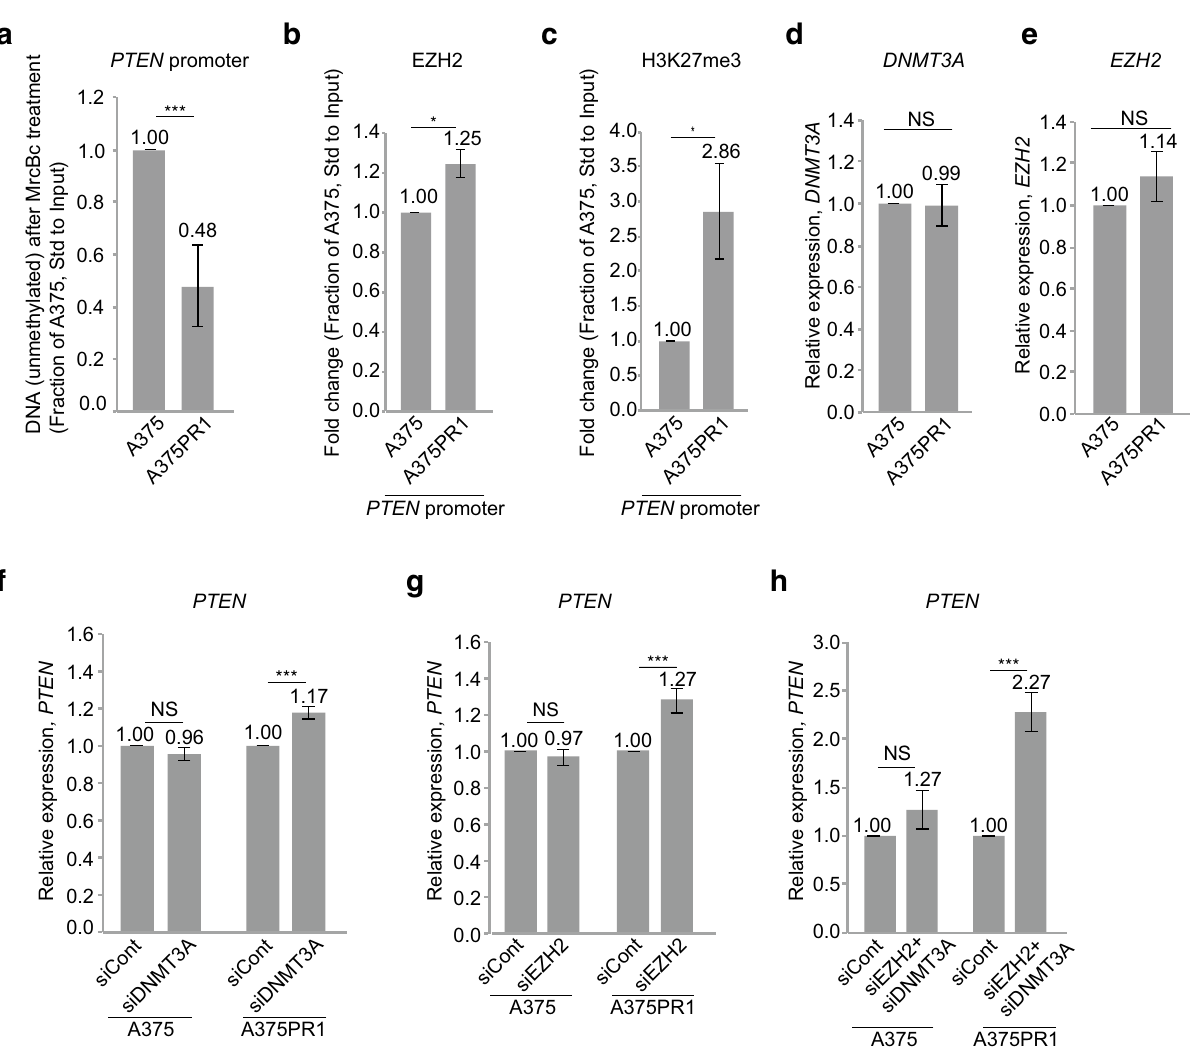
Figure 3. Characterization of the PTEN promoter in A375 and A375PR1 cell lines. ( a ) qRTPCR measuring PTEN promoter CpG methylation, as determined by the remaining (unmethylated) DNA upon treatment with the methyl-cytosine-specific restriction enzyme McrBc (n = 3). ( b–c ) ChIP followed by qRTPCR analysis measuring the levels of ( b ) EZH2 and ( c ) H3K27me3 at the PTEN promoter in A375 and A375PR1 cell lines (n = 3). ( d – e ) qRTPCR measuring baseline expression levels of ( d ) DNMT3A and ( e ) EZH2 in A375 and A375PR1 cell lines (n = 3). ( f – g ) qRTPCR measuring the expression levels of PTEN following siRNA induced knockdown of ( f ) DNMT3A and ( g ) EZH2 in A375 and A375PR1 cell lines (n > 3). ( h ) qRTPCR measuring the expression levels of PTEN following simultaneous siRNA-induced knockdown of EZH2 and DNMT3A in A375 and A375PR1 cell lines (n = 3). ( a – h ; p-values represent a two-tailed student’s